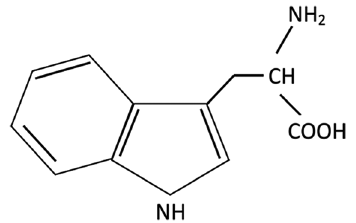
Figure-1: Chemical structure depiction of Tryptophan